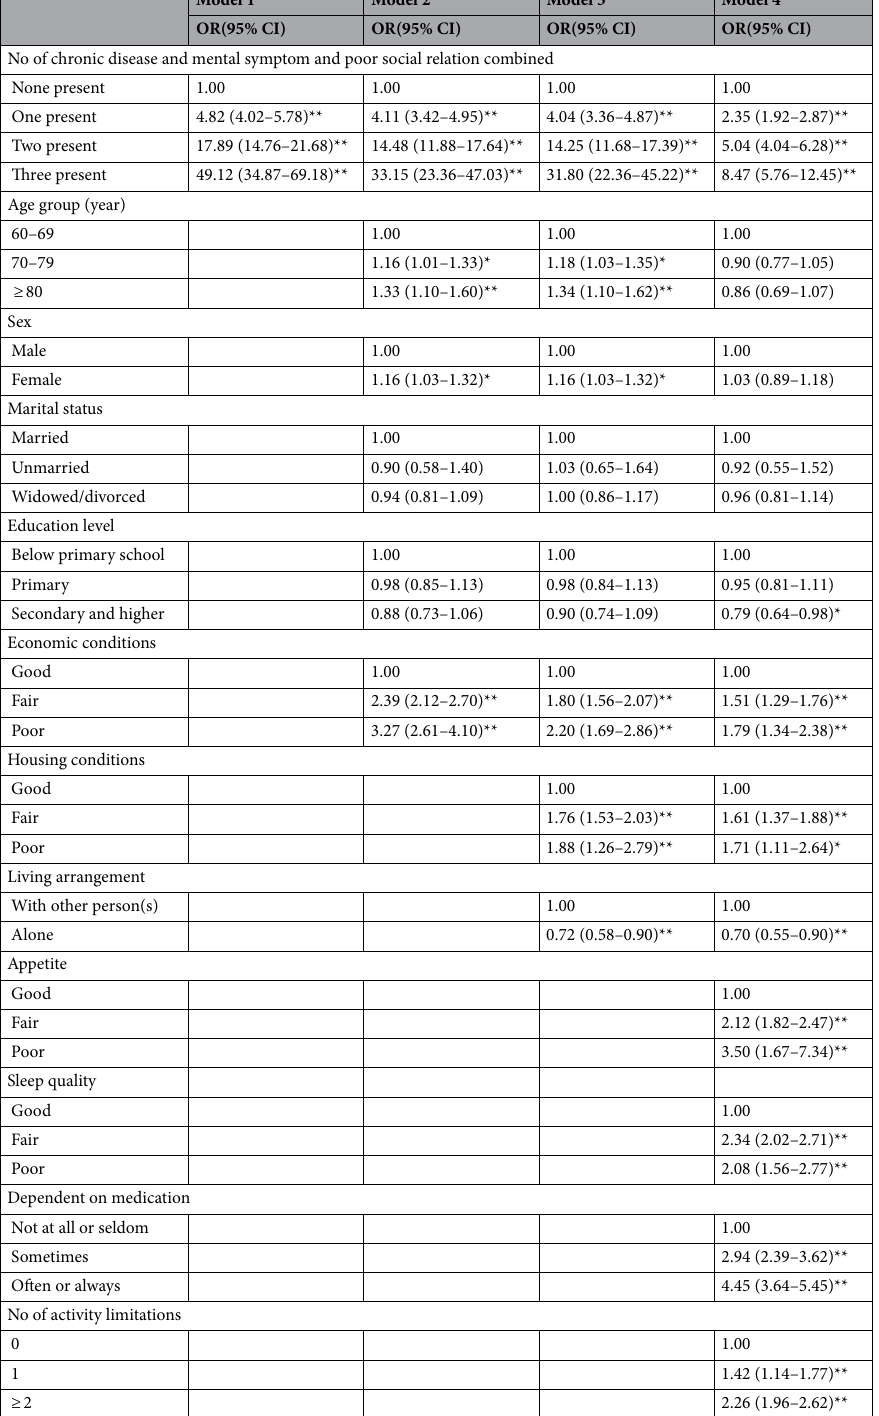
Table 5. Multivariate analysis of the relationship of co-occurrence of chronic disease and mental health symptom and poor social relation with self-rated health. *The reference category is subjects without the specified condition, P < 0.05. **The reference category is subjects without the specified condition, P <